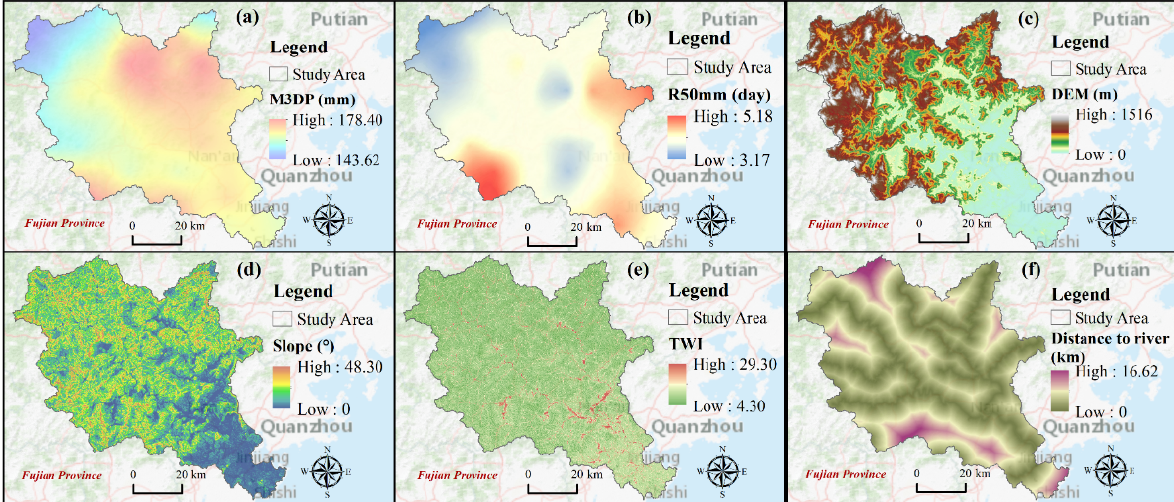
Figure 2. Disaster-inducing factors: ( a ) maximum three-day precipitation (M3DP), ( b ) number of days with daily rainfall ≥ 50 mm (R50 mm); disaster-breeding environments: ( c ) digital elevation model (DEM), ( d ) slope, ( e ) topographic wetness index (TWI), and ( f ) distance to river (DR).